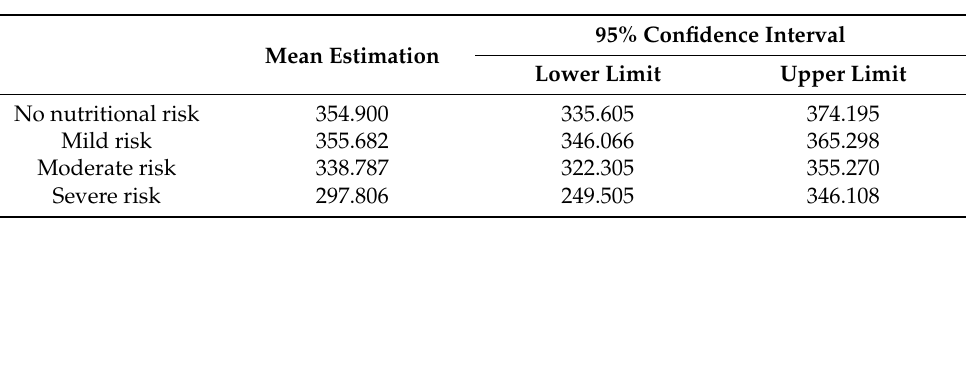
Table 7. Analysis with the nutritional estimate using CONUT at hospital